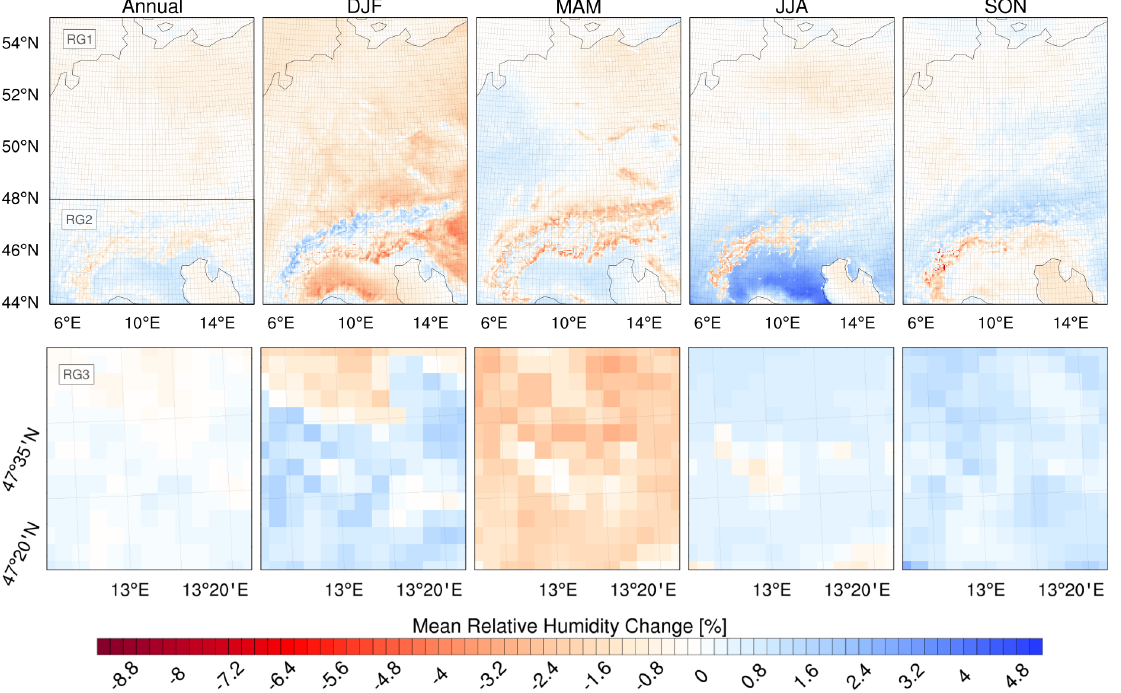
Figure 16. Projected changes 2020–2049 (scenario RCP4.5) compared to 1980–2009 for relative humidity for RG1, RG2 (top row), and RG3 (bottom row). Annual, winter (DJF), spring (MAM), summer (JJA), and fall (SON) changes are displayed (from left to